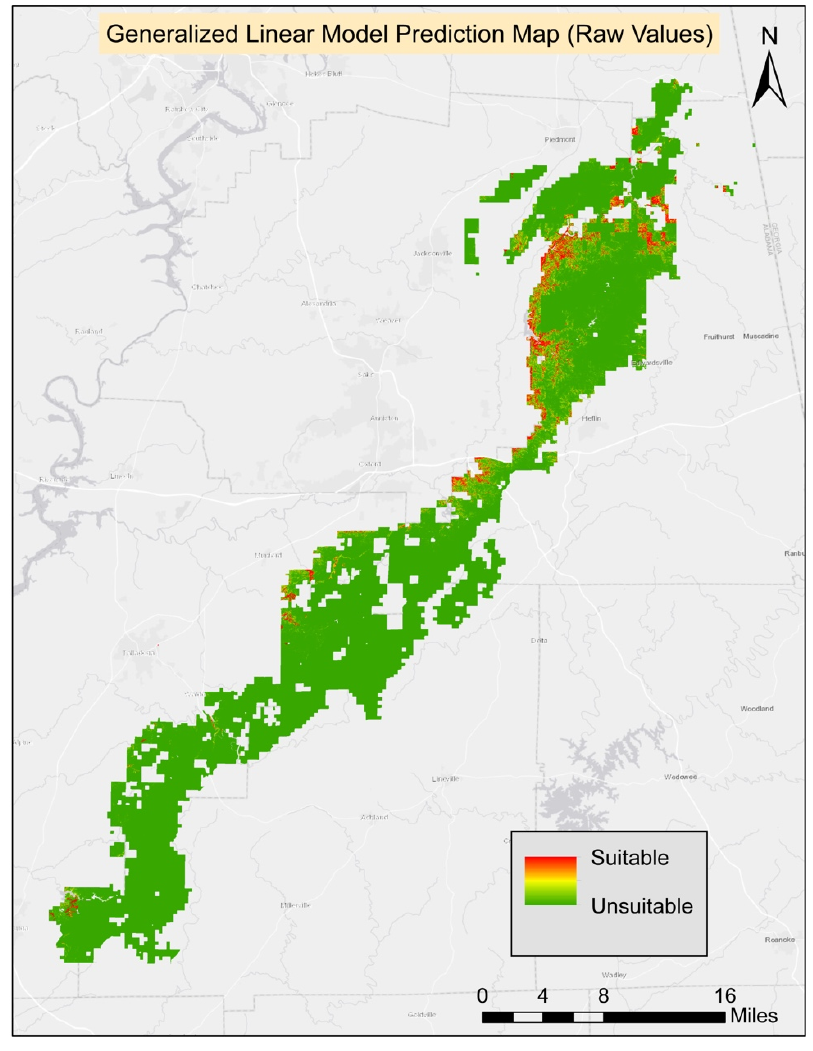
Figure A2. Xerophyllum asphodeloides (turkeybeard) Generalized Linear Model habitat suitability map.